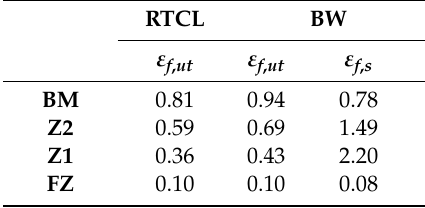
Table 1. Calibrated parameters for the RTCL and BW